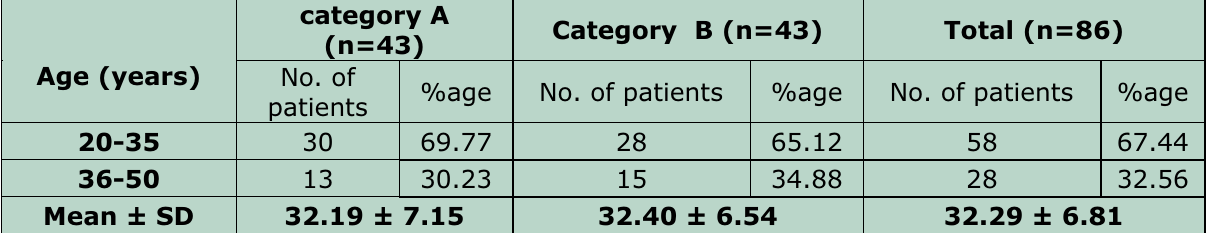
Table-I: Age distribution for both categories (n=86).